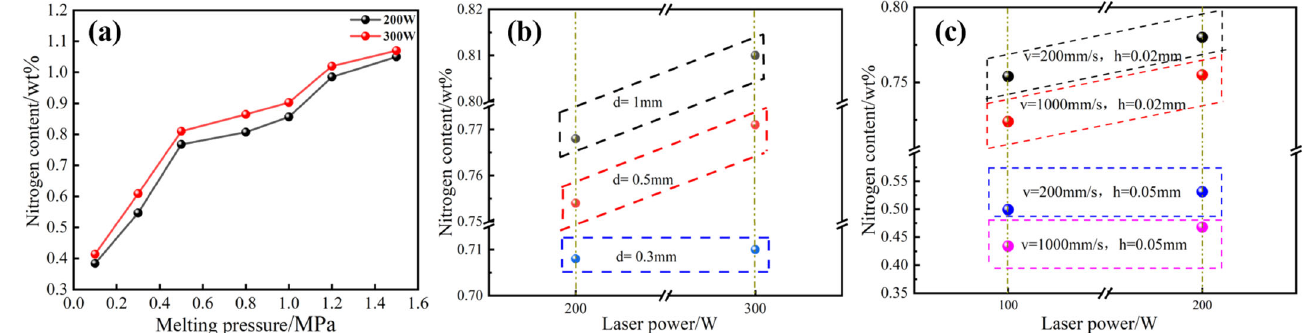
Figure 4. Analysis of nitrogen content in SLM samples with: ( a ) different cavity pressures; ( b ) different layer thicknesses; ( c ) different scanning intervals.